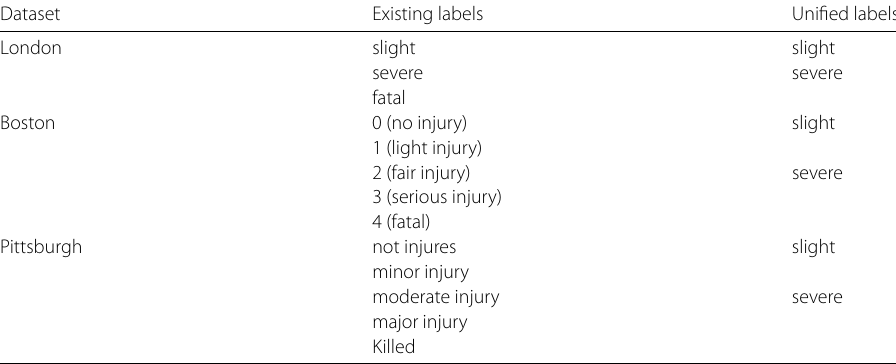
Table 2 Label matching between datasets